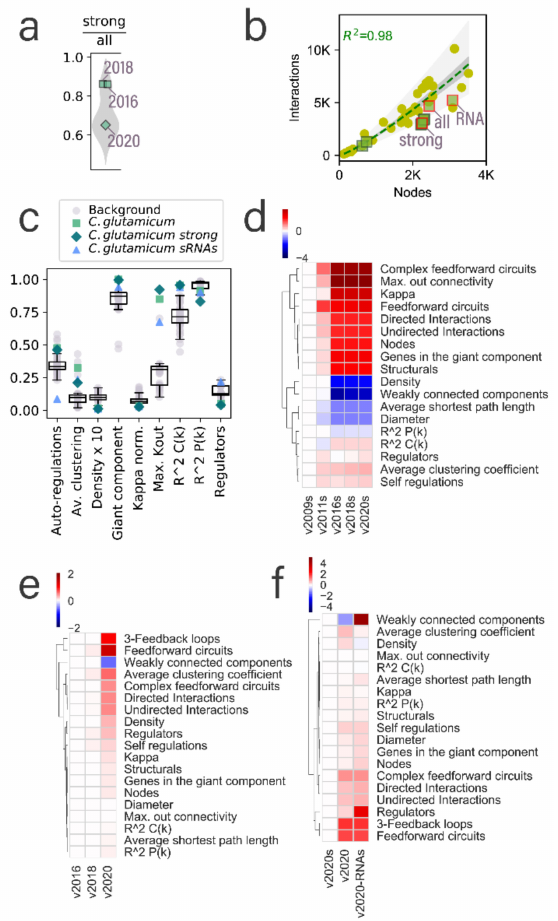
Figure 2. Structural properties of the C. glutamicum networks. ( a ) Distribution of the fraction of the strong interactions in the all evidence networks, including at least one strong interaction. C glutamicum networks are highlighted and labeled. 2009 and 2011 versions of the C. glutamicum network are not included as they do not have a cognate all evidence network. ( b ) Inclusion of the three networks presented in this work into the previous model reported in [1] for the inference of the number of interactions for the regulatory networks. C. glutamicum networks are marked with green squares, and the three networks reported in this work are highlighted with a red outline and labeled. The rest of the data points (yellow dots) are the rest of the Abasy Atlas database used for reference. ( c ) Comparison of C. glutamicum structural properties with the nonredundant set of bacterial networks used as background. Boxplots were drawn, including the nonredundant data set and the C. glutamicum networks reported in this work. ( d ) Heatmap values are the log2-fold change of the C. glutamicum regulatory networks for strong networks of versions 2011, 2016, 2018, and 2020, relative to the earliest strong version (2009). The v2009 column is included for clarity. Properties are clustered to ease the identification of those that have increased, decreased, or remained virtually unchanged. Heatmaps ( e , f ) also represent the log2-fold change values relative to the leftmost column of ( e ) for versions of the all evidence network and ( f ) for the three different network models presented in this work to highlight the impact of the inclusion of sRNA-mediated interactions into the structural properties of the